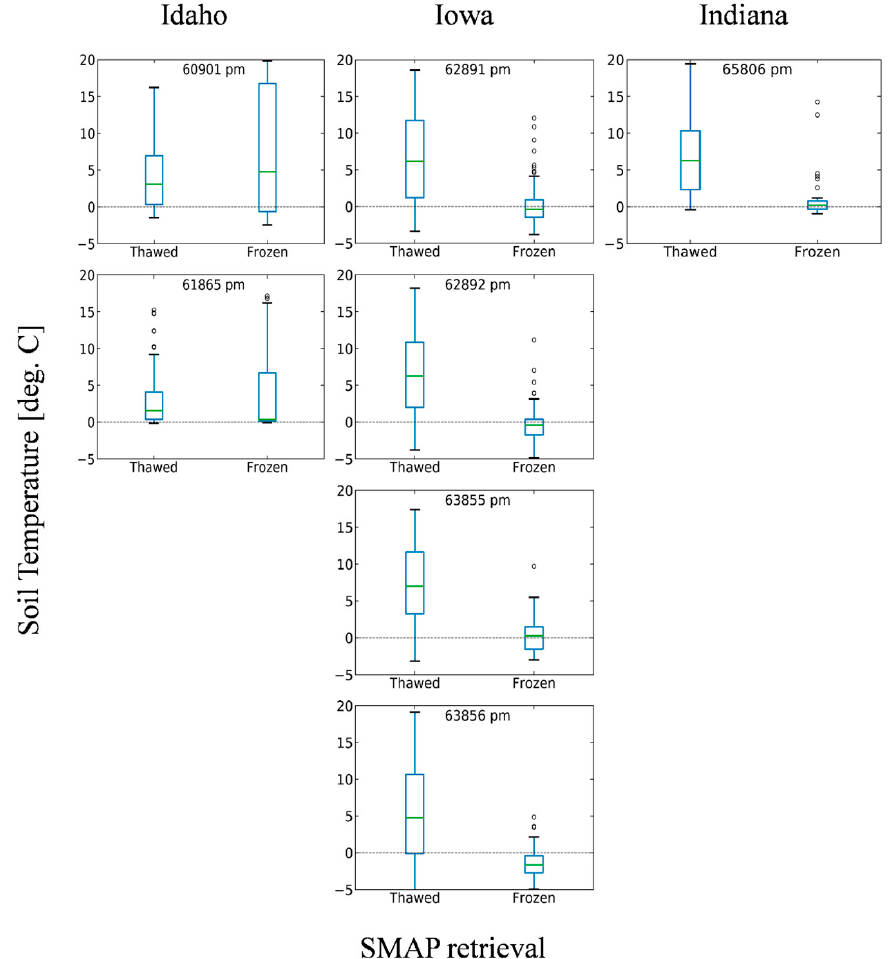
Figure 7. Boxplots of in situ soil temperature for (1) SMAP retrieved as thawed and (2) SMAP retrieved as frozen during winter (October–March). The box shows the 25th to 75th percentile range of soil temperatures. Whiskers extend to the last data point that is inside the 75th percentile value + 1.5 × IQR, in which IQR is the interquartile range (the 75th percentile—25th percentile value). Only points that lie outside this range are plotted. The green line is plotted at the median value of the dataset.